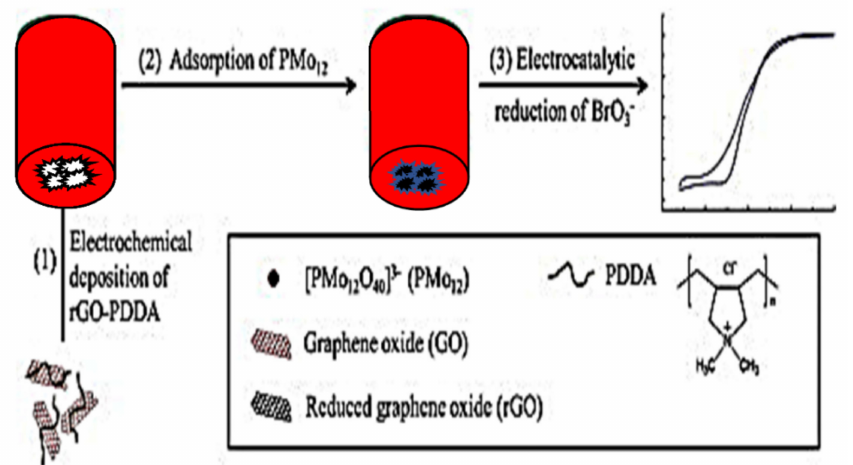
Figure 3. Schematic illustration of the principles of the fabrication of a PMo 12 @rGO-PDDA/GCE and the catalytic reduction of bromate (adapted from [16] with